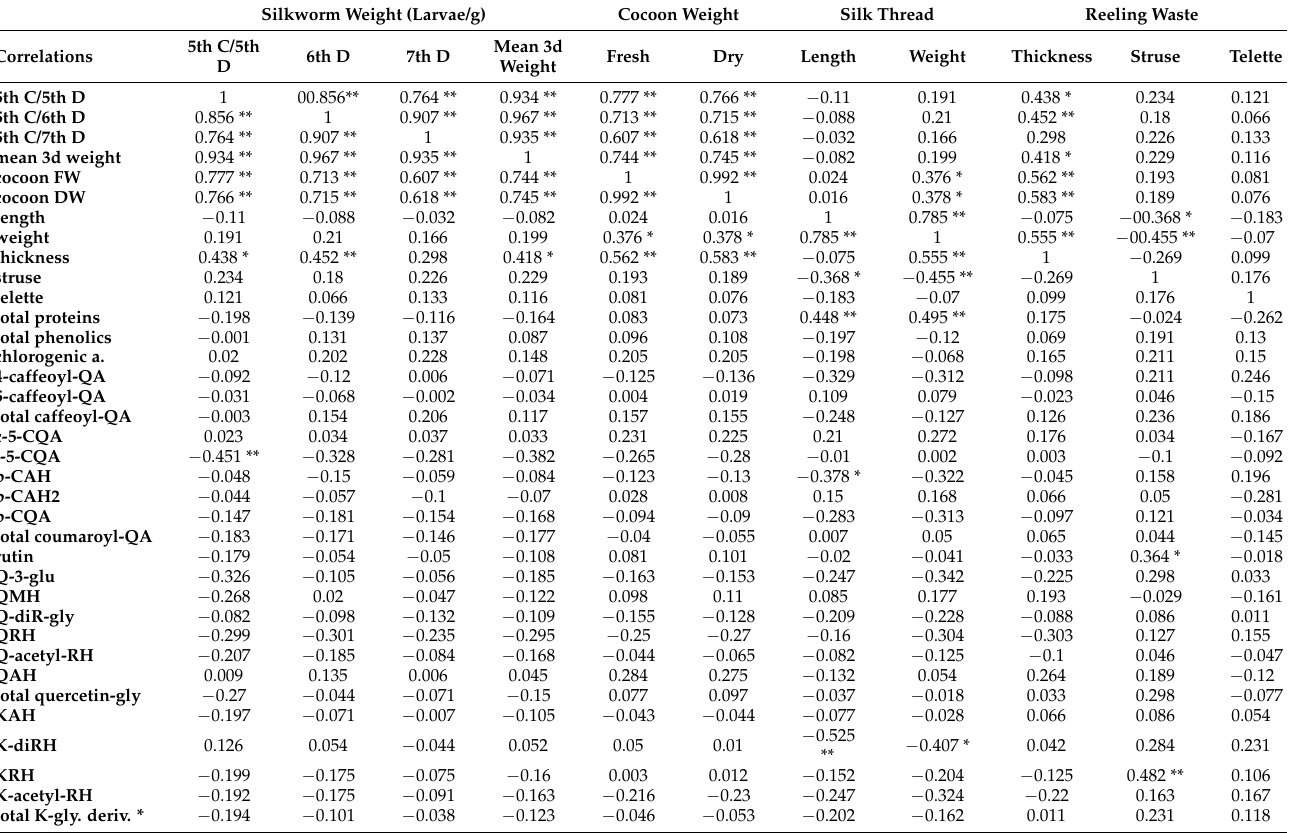
Table 5. Pearson’s correlation coefficient between silkworm, cocoon, and raw silk parameters in relation to the main phenolics ( n = 32) in mulberry leaves listed according to their retention times on HPLC.